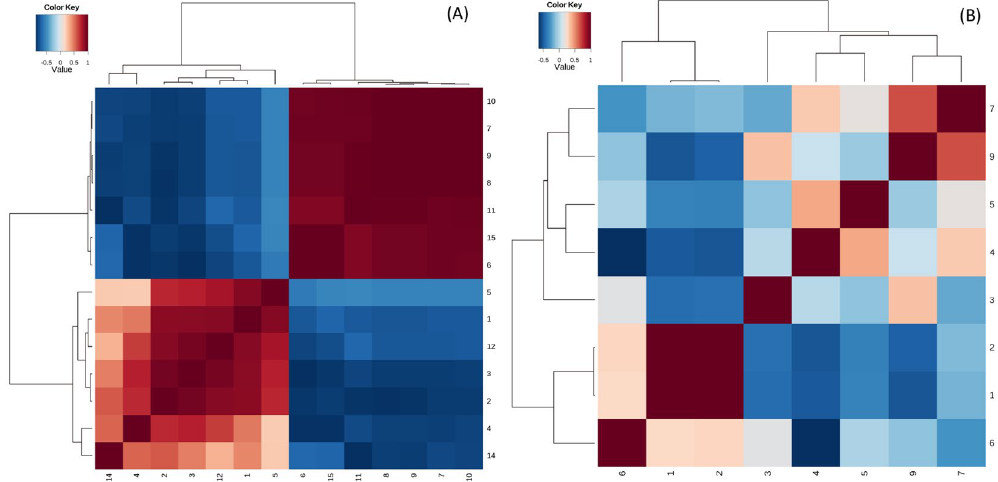
Figure 10. Correlation analysis of the differential metabolites on day ( A ) 21 and ( B ) 35 are marked on the S-plots. Numbers consist with Tables 1 and